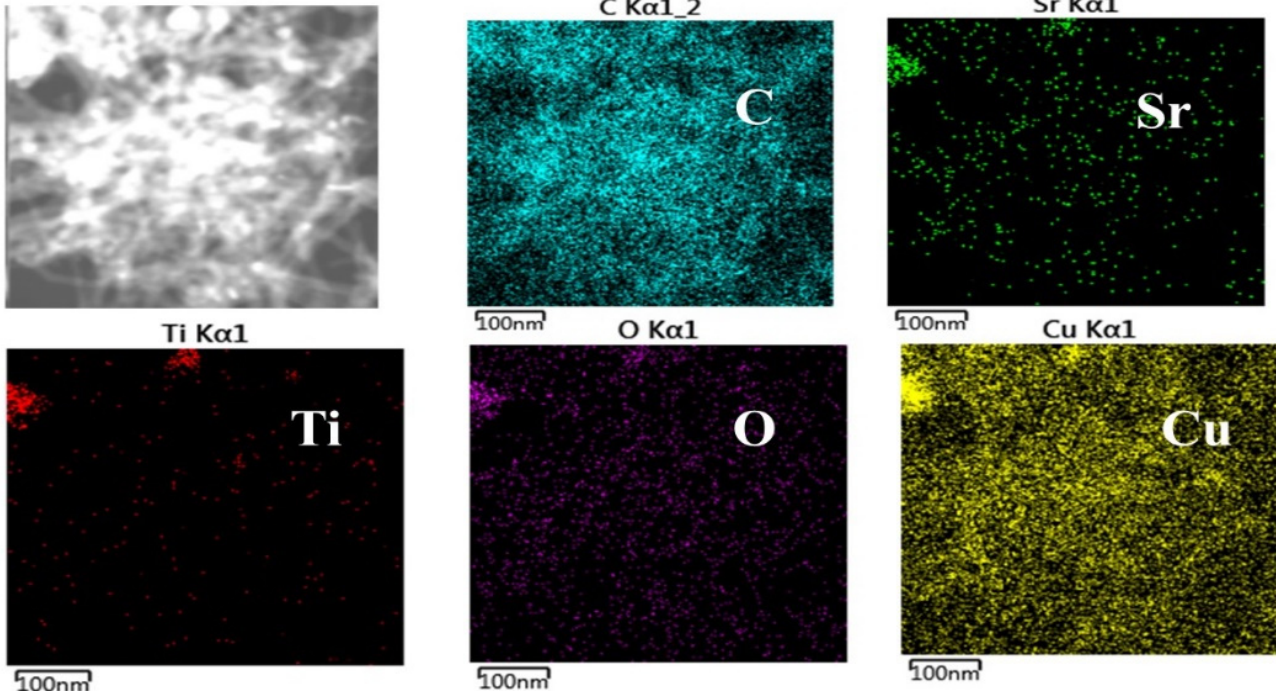
Figure 6. DF-STEM micrographs and EDX element mapping images of 5% CuO/STO/MWCNTs.